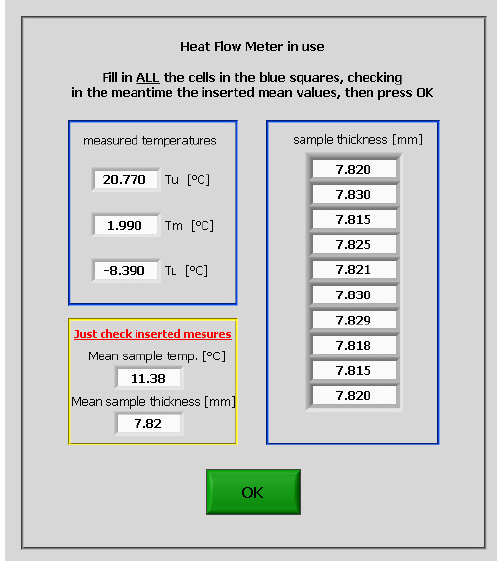
Fig. 8. (Color online) Software Snapshot – Sheet 2: measured